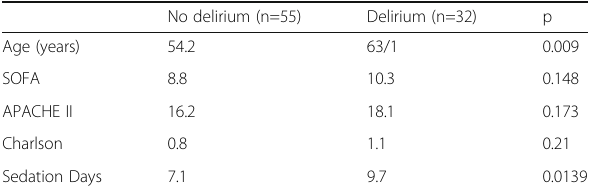
Table 1 (abstract 0376). Baseline